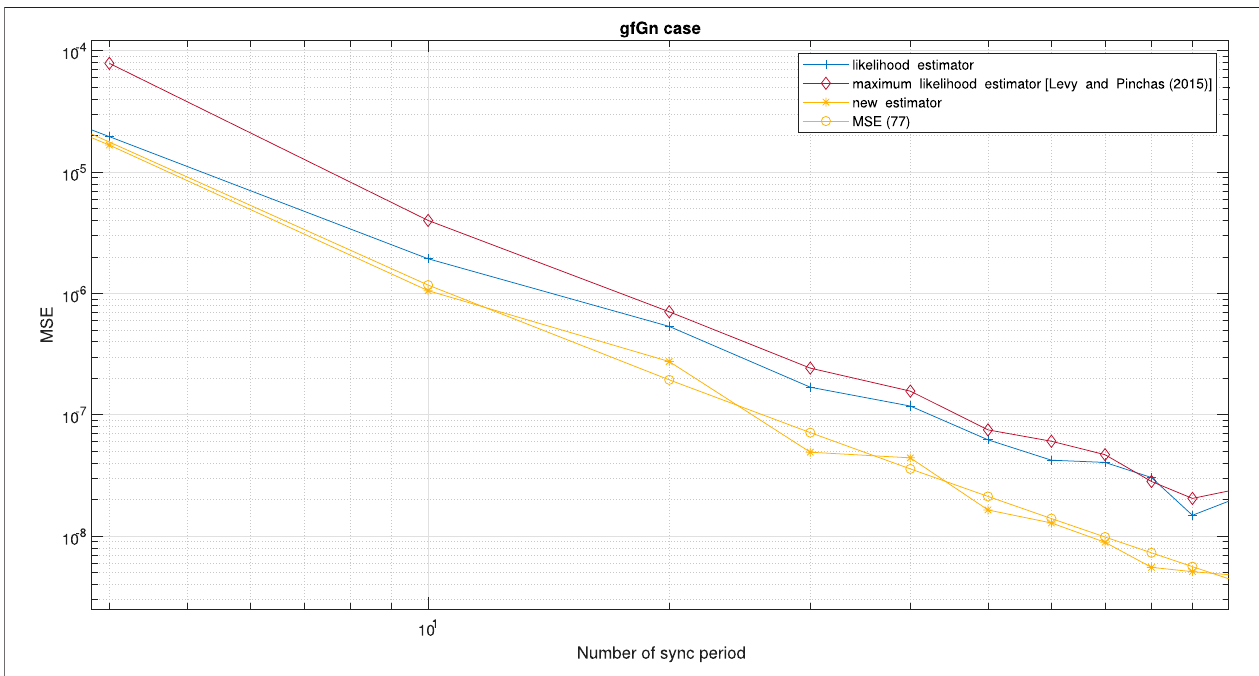
FIGURE11| Performancecomparisonbetweenthenewclockskewestimator Eq.3 forthegfGncasewiththeclockskewestimatorofNohetal.[34]andLevyand Pinchas[2].TheclockskewestimatorofNohetal.[34]isdenotedhereasthelikelihoodestimator.Wealsohavethesimulatedperformanceresultsforournewproposed expression for the MSE Eq. 77 for the gfGn case. α (cid:1) 50 ppm , Q (cid:1) 5 ms , T syn (cid:1) 15.6 ms , σ ω were obtained for 100 Monte-Carlo trails.